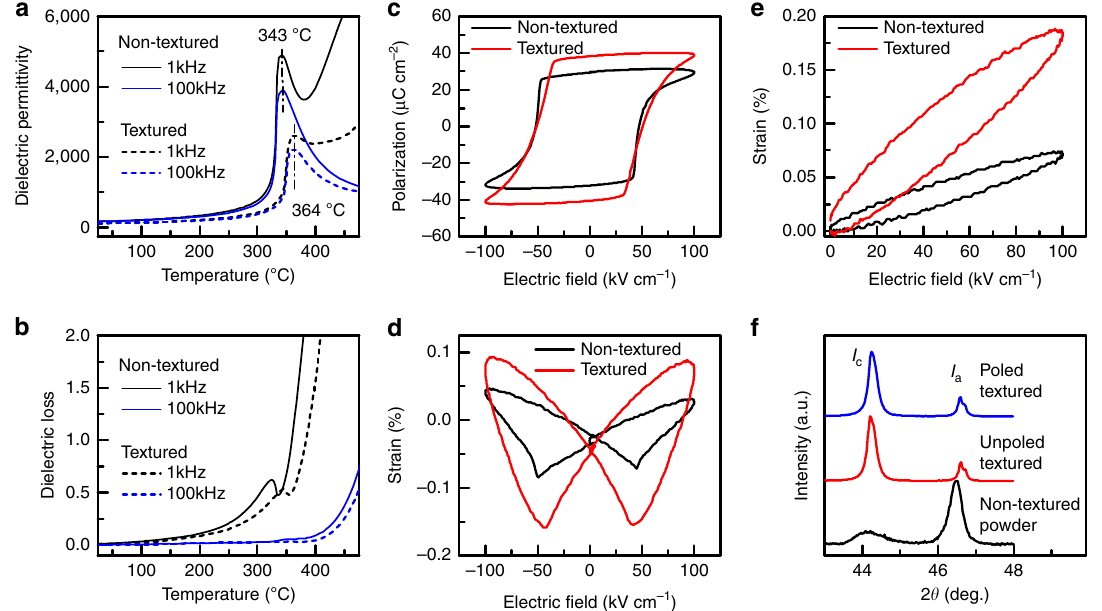
Figure 3 | Dielectric, ferroelectric and piezoelectric properties. ( a ) Dielectric permittivity and ( b ) dielectric loss as a function of temperature for non-textured and textured SM-PT samples. The vertical dash-dot lines are used for indicating Curie temperature. ( c ) Polarization, ( d ) bipolar strain, and ( e ) unipolar strain as a function of electric field at 75 (cid:2) C for non-textured and textured samples. ( f ) X-ray diffraction patterns of non-textured matrix, unpoled and poled textured ceramics, where I c is the intensity of (002) peak and I a is the intensity of (200)/(002) peaks.